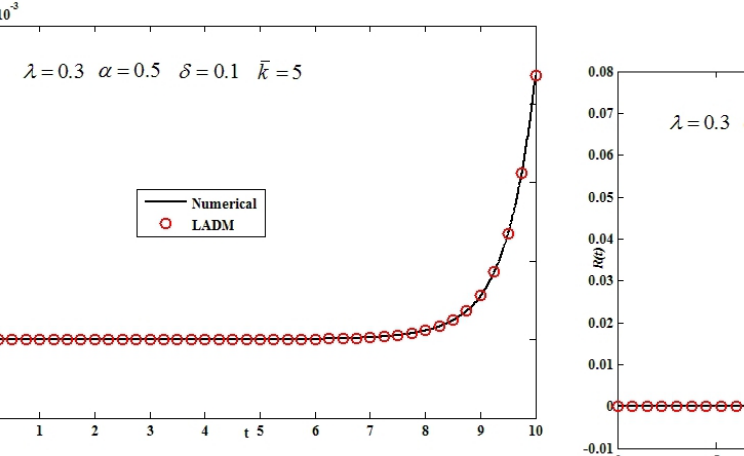
Fig. 6. Comparison of the LADM solutions of S(t) with numerical method.